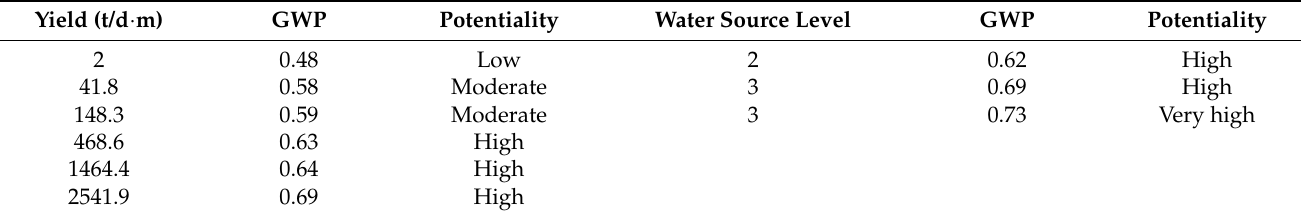
Table 7. Comparison of borehole yield rate, water source level, and groundwater potential